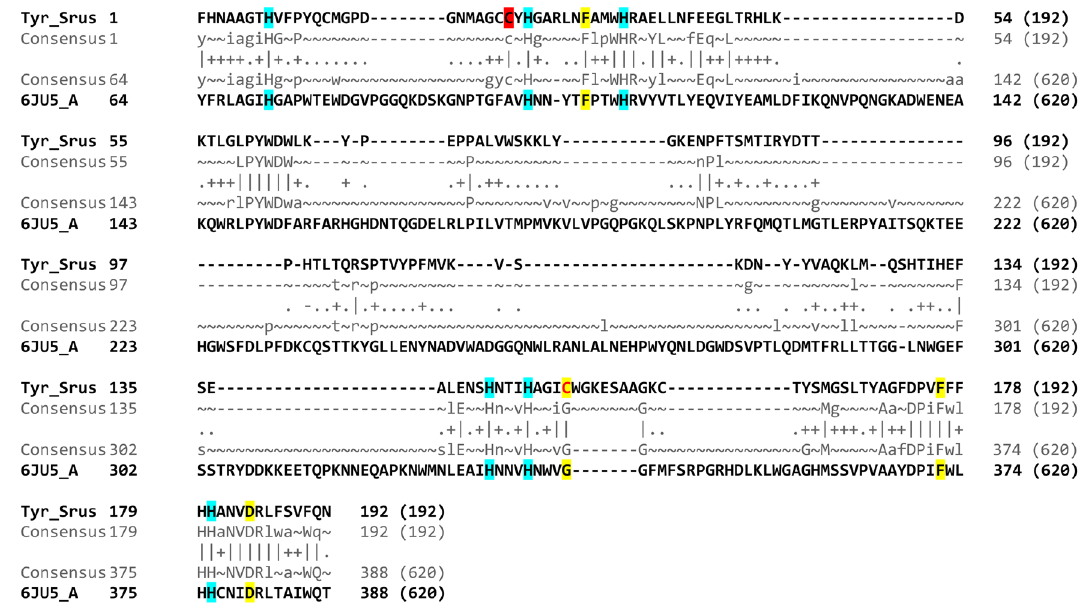
Figure 5. Results of HHpred search. Pairwise alignment and alignment of consensus sequences for tyrosinase domain of S. rustica Tuphoxin (Tyr_Srus) and Aspergillus oryzae (6JU5_A) tyrosinase region between 64 and 388 amino acids. Conservative histidines binding the Cu-ion highlighted in blue, amino acids specific for alfa tyrosinases 19 highlighted in yellow with substitution typed red, cysteine forming the covalent linkage with histidine 51 highlighted in